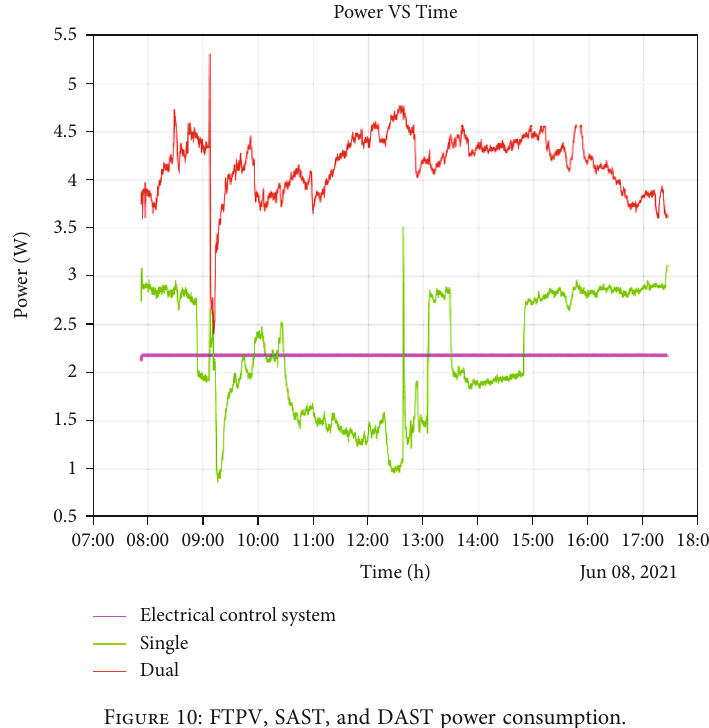
Figure 10: FTPV, SAST, and DAST power consumption.